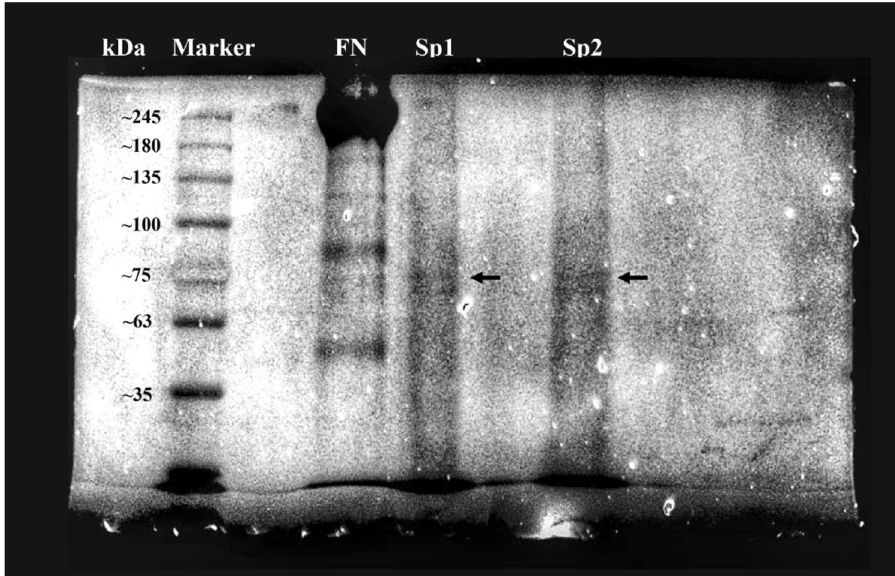
Figure 6. SDS-page analysis of Spidroin solution. FN: Fibronectin; Sp1: Spidroin sample 1; Sp2: Spidroin sample 2. FN used as a control. Black arrow is the protein target band.